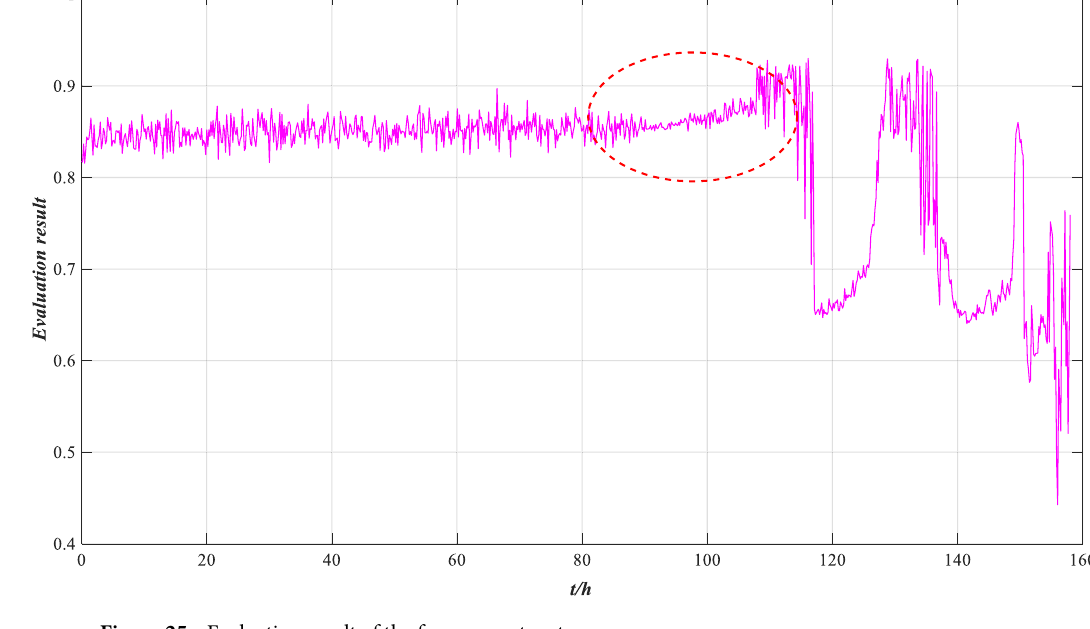
Figure 25. Evaluation result of the fuzzy expert system.